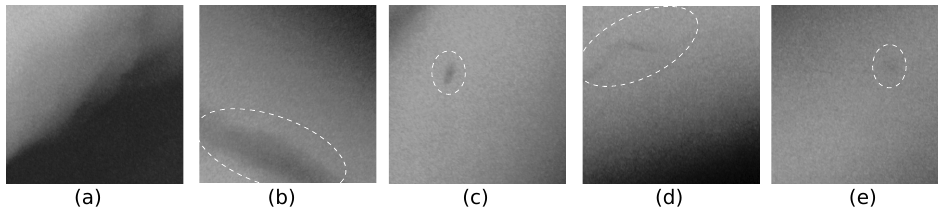
Figure 2. Examples of patches in the training and test datasets: ( a ) is weld okay, accepted weld, ( b , c ) are high contrast defects, ( d ) is a mid-contrast defect, and ( e ) is a low contrast defect. Adapted from [37] with permission from ASME.